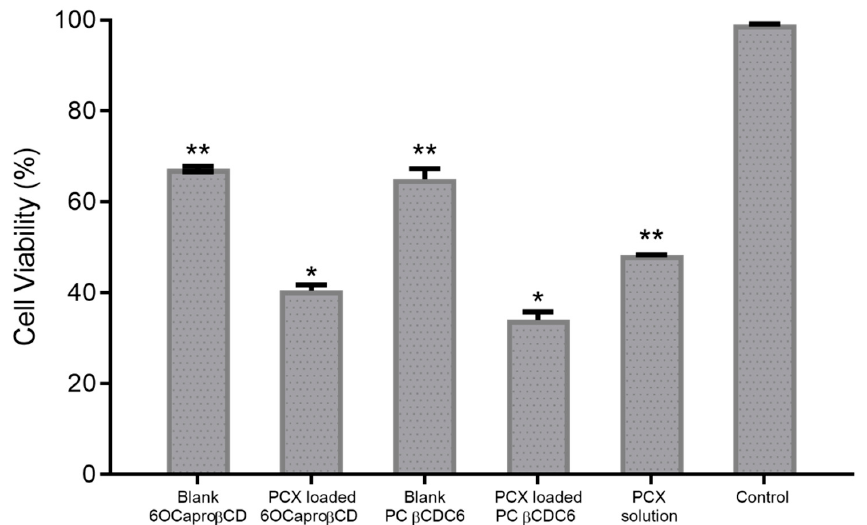
Figure 2. Anticancer effect of blank or paclitaxel-loaded amphiphilic cyclodextrin nanoparticles and paclitaxel solution against 2D 4T1 murine breast cancer cell line. Cell viability was evaluated by WST-1 assay. (n = 6, mean ±SD), (* p < 0.05 compared with PCX solution and ** p < 0.05 compared with control group) .